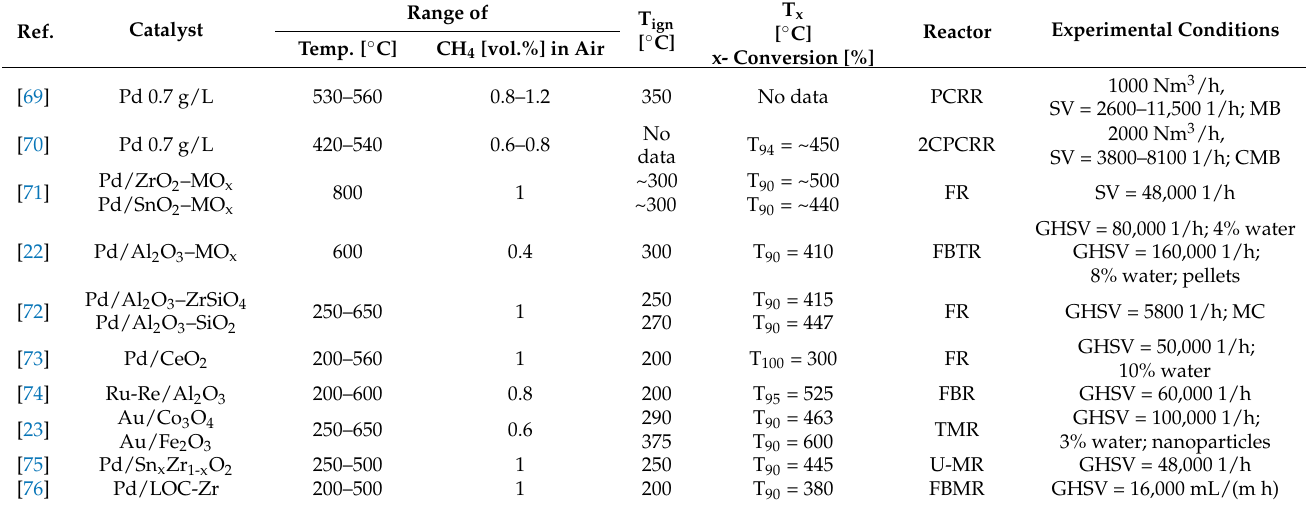
Table 4. The chosen catalysts proposed for the combustion of lean methane–air mixture such as VAM.